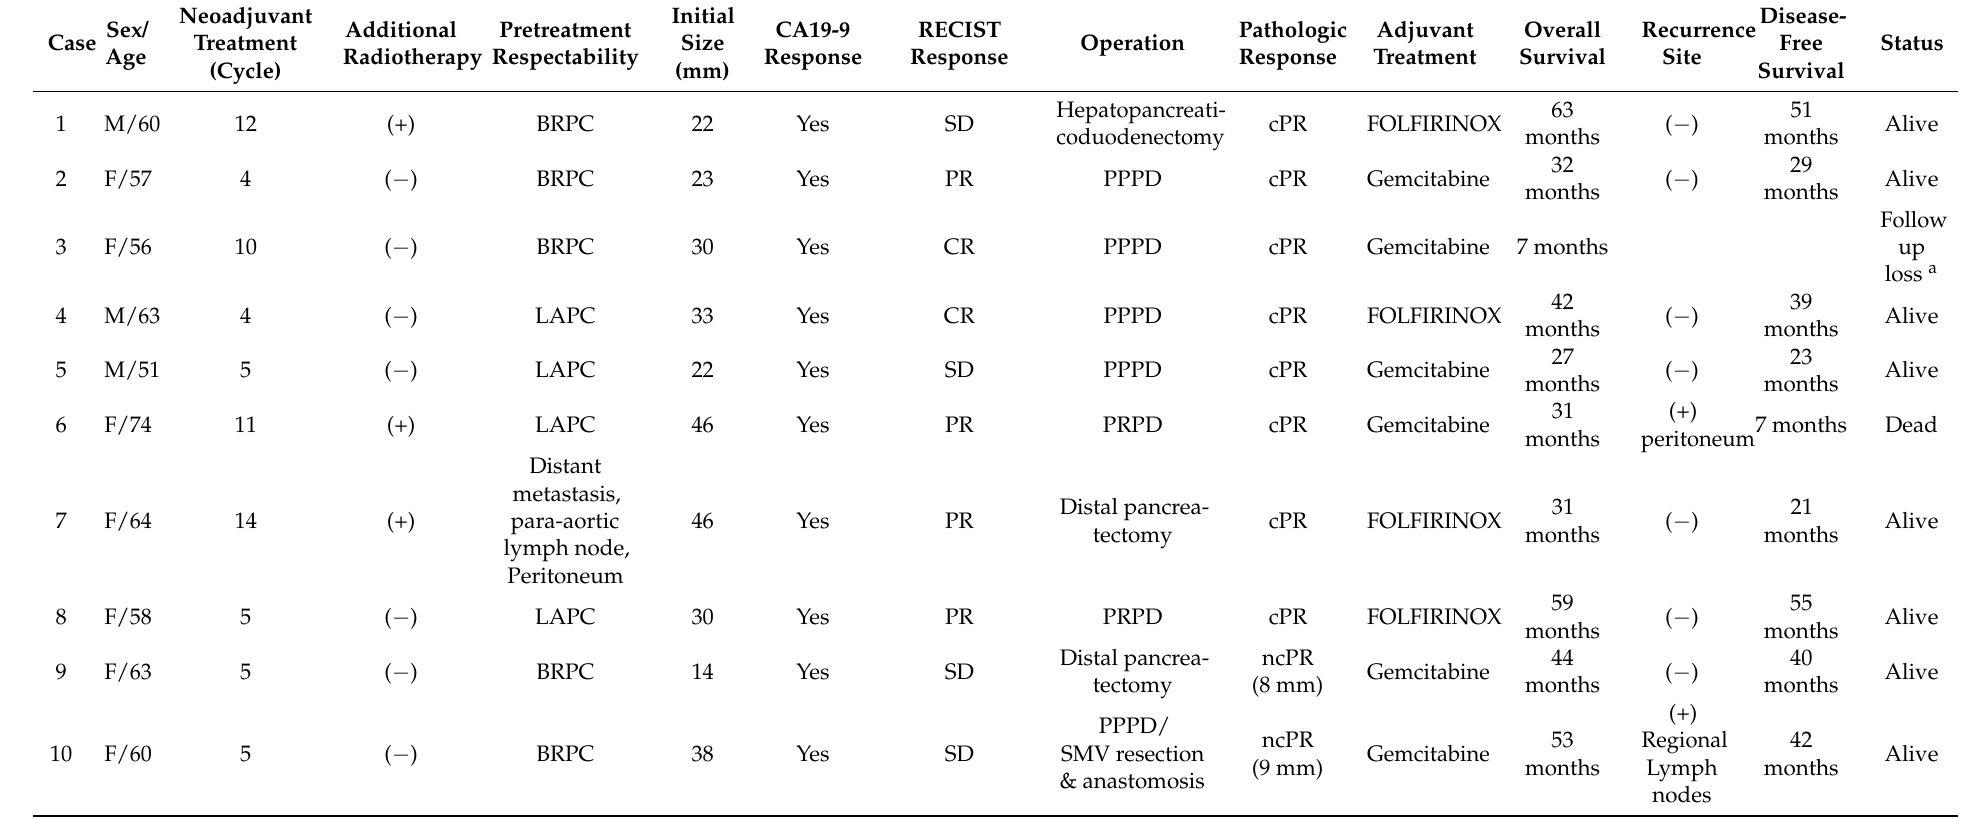
Table 4. Details on the clinical course of patients with pathologic complete response and nearly pathological complete response after neoadjuvant